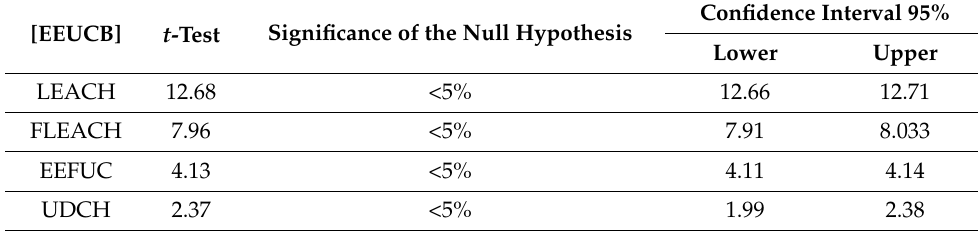
Table 7. The energy consumption with different scenarios.